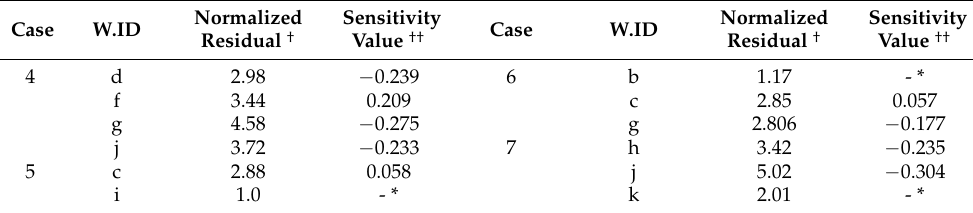
Table 9. Normalized residuals and sensitivity for the detection and replacement of bad data. Normalized Case W.ID